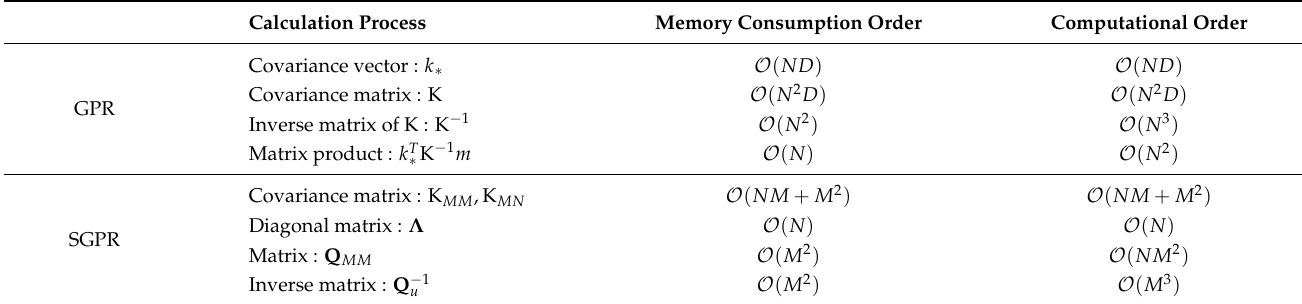
Table 3. Memory and computational cost for each computational process in GPR and SGPR. N is input data points, D is input dimensions, and M is inducing